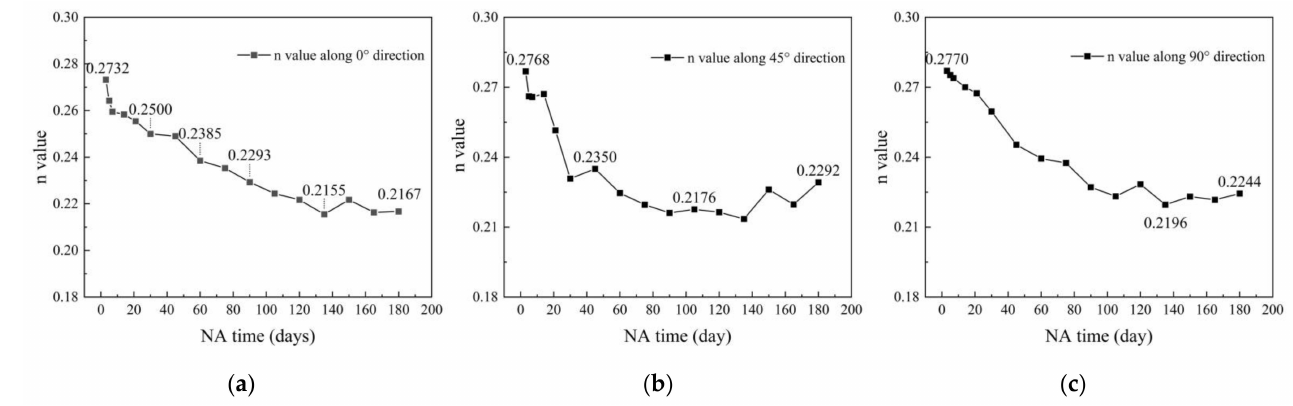
Figure 9. The change curves of n value along 0 ◦ ( a ), 45 ◦ ( b ), and 90 ◦ ( c ) directions during six months of NA.